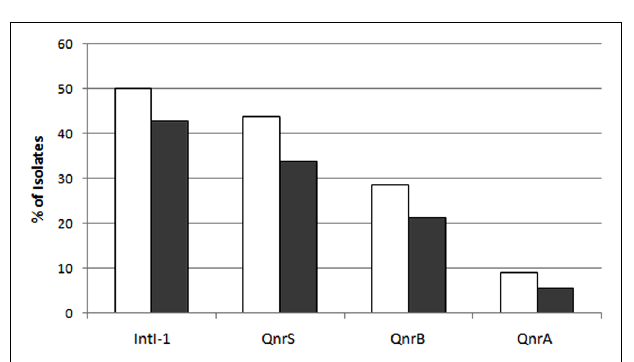
FIGURE 4 |The abundance of the different variants of qnr and of the intl-1 genes in sludge (white bars) and raw sewage (gray bars) intermediate ciprofloxacin-resistant